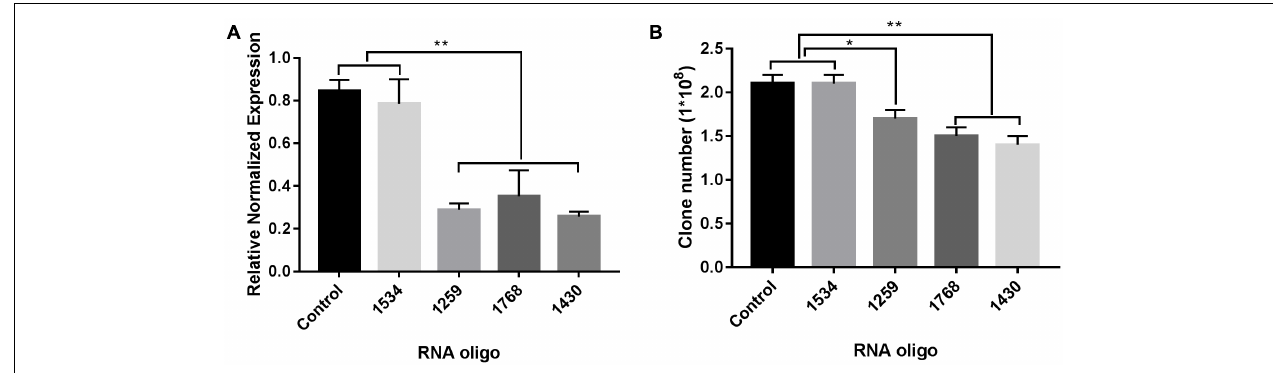
FIGURE 6 | RNA silencing of FabG reduced bacterial colony counts. Using the RNA oligo pairs shown in Supplementary Table S2 (GenePharma Co., Ltd, Shanghai, China) to target FabG from P. aeruginosa , RNAi was carried out with a GenePulser Xcell system using a 2 mm cuvette with the default settings for